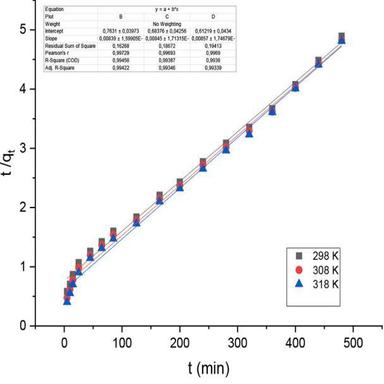
The plot of pseudo-second-order kinetic.